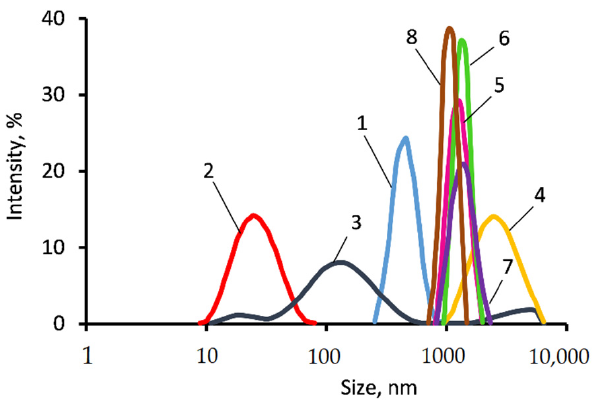
Figure 4. Particle size distribution in the environment of toluene for PEO (1), TEOS (2), PEOASiP (3), AGM (4), ASiP–AGM-10 (5), ASiP–AGM-30 (6), ASiP–AGM-50 (7) and ASiP–AGM-100 (8).